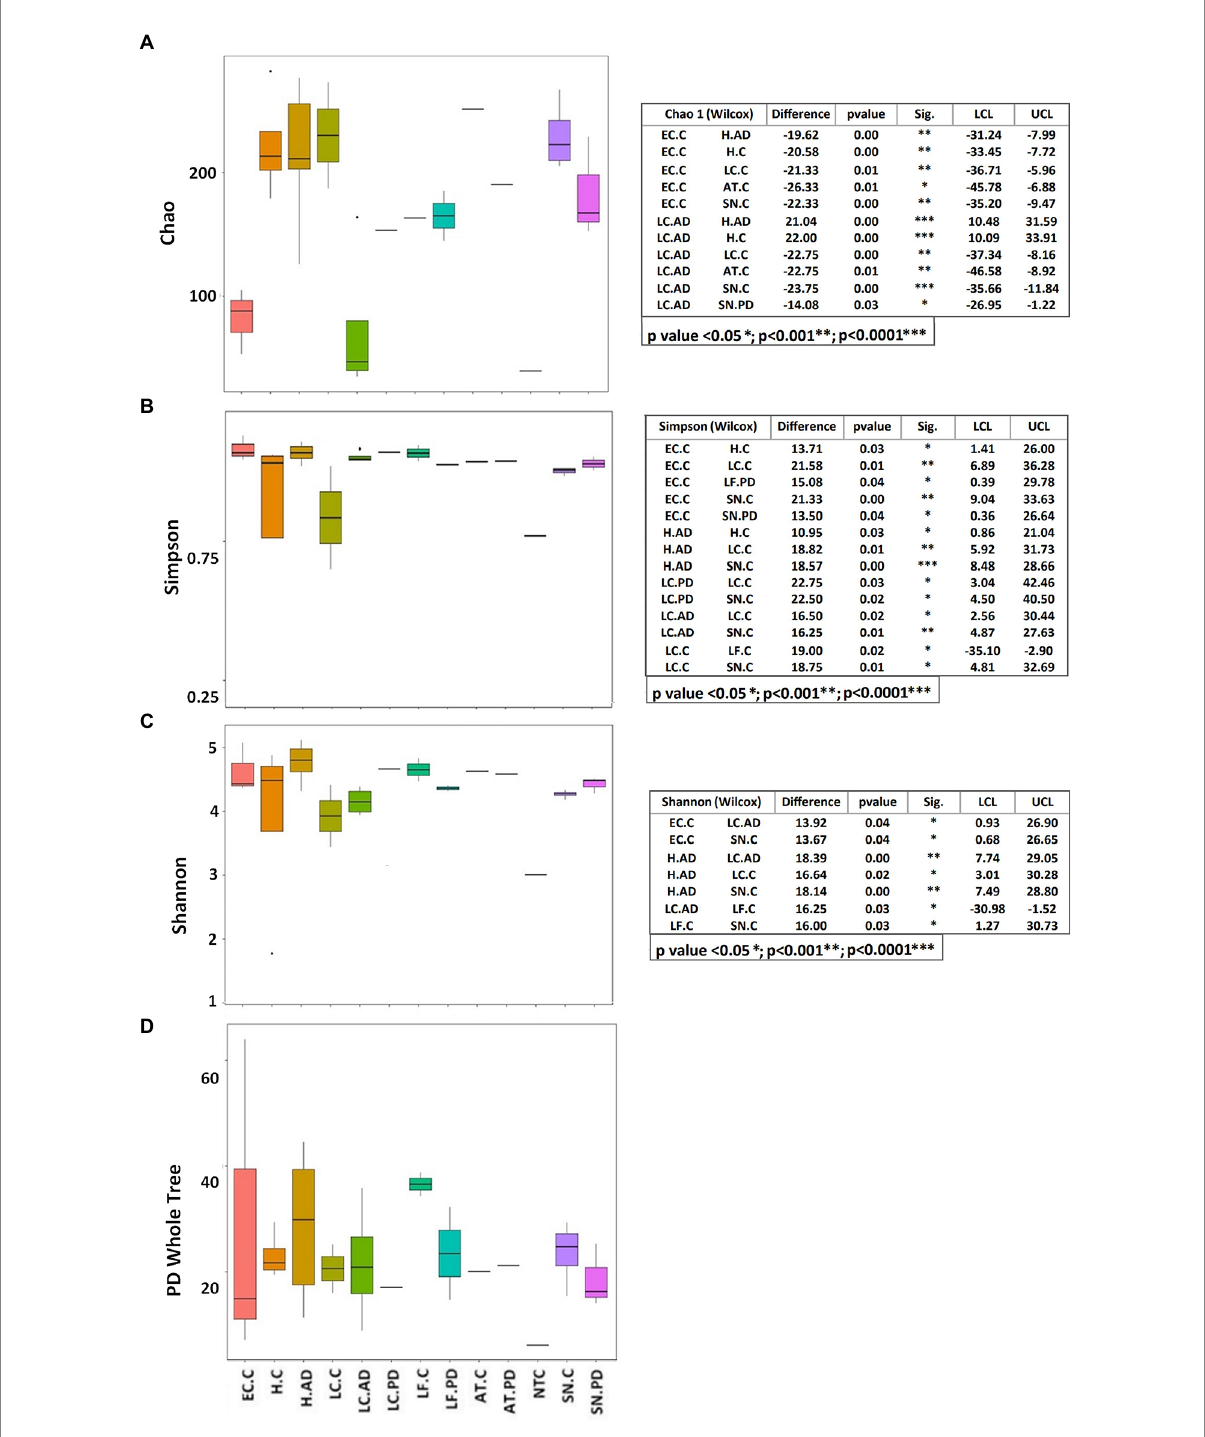
FIGURE 5 Alpha diversity indices displayed as boxplots with significant differences between groups calculated by the Wilcoxon test. (A) Chao, (B) Simpson, (C) Shannon, (D) PD (phylogenetic diversity) whole tree. AD, Alzheimer’s disease; C, control; PD, Parkinson’s disease; AT, anterior temporal cortex—BA38; EC. entorhinal cortex (BA34); H, hippocampus; LC, locus coeruleus; LF, lower pre-frontal cortex (BA11); NTC, No template Control; SN, substantia